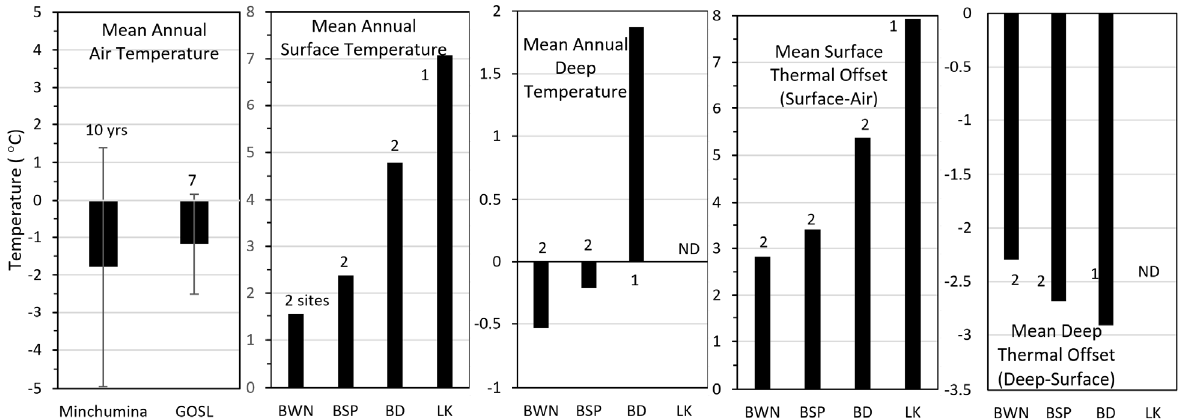
Figure 13. Mean annual temperatures for air at Gosling Lake (7 years) and Lake Minchumina (10 years), and surface ( − 5 cm), and deep (100 cm) temperatures by hydrologic year (October–September) for black spruce bogs (BWN, 2 sites, 7–9 years), post-fire scrub bogs (BSP, 2 sites, 5–9 years), ericaceous bogs (BD, 2 sites, 2–4 years), and the lake bottom (LK, 1 site, 7 years). Mean thermal offset for the surface (surface air) and deep soils (deep surface) also shown.